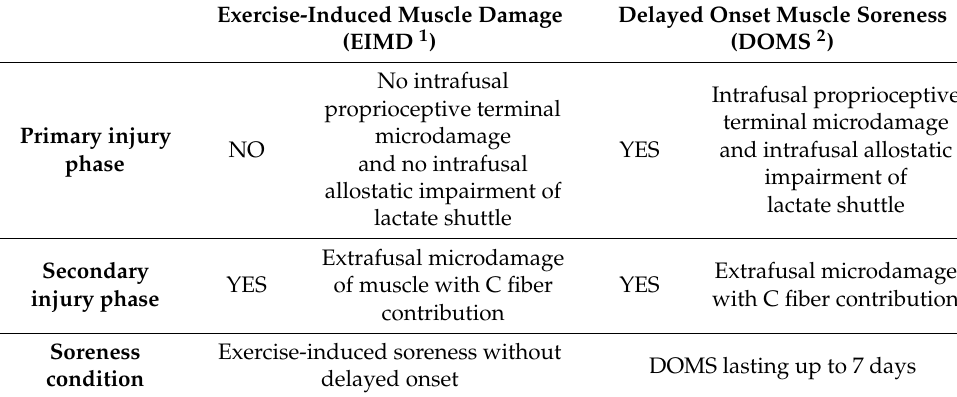
Table 1. Microinjury mechanism in EIMD and DOMS *, adapted from exercise-induced microdam- ages